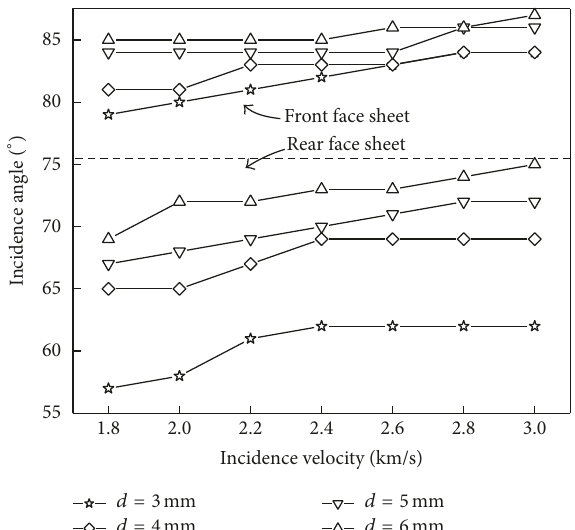
Figure 11: Critical perforation angles under various diameter and velocity of